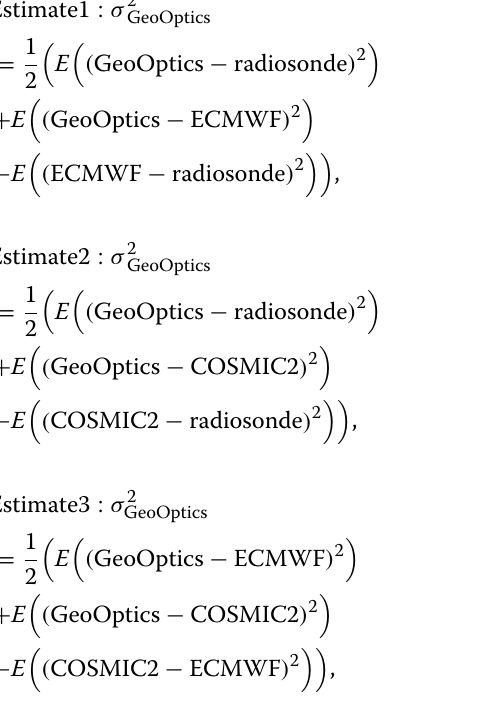
Fig. 14. 3CH estimates of refractivity error standard deviation of radiosonde (pink), ECMWF analysis (yellow), COSMIC-2 (green), GeoOptics (blue). The mean standard deviation of differences between GeoOptics and each of the other data sets is shown with black dash-dotted curve. The counts are shown by the black dotted